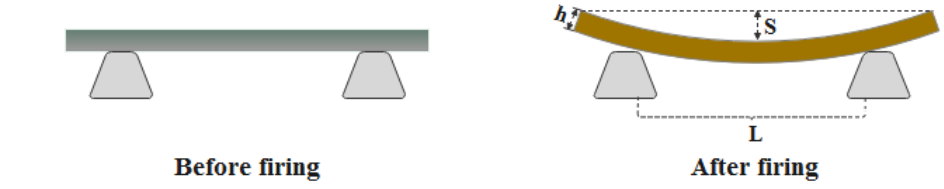
Figure 1. Position of the green bar and deformed sample before and after firing.